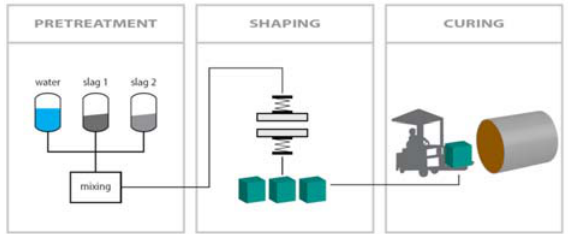
Figure 3. Schematic drawing of the accelerated carbonation process developed for stainless steel slag by